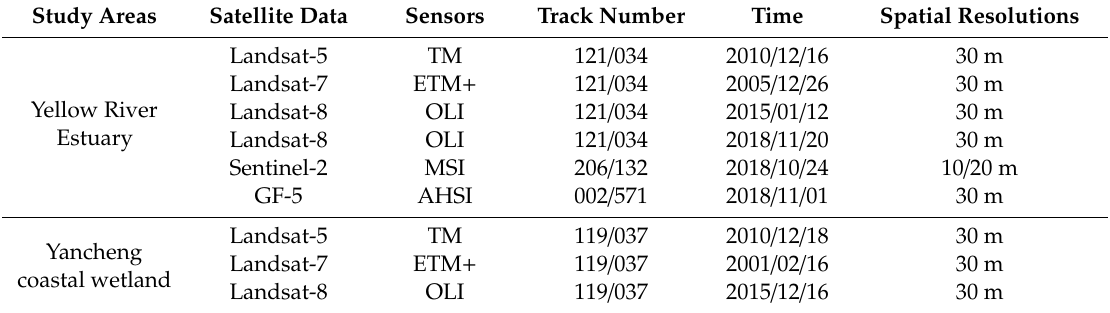
Table 1. List of satellite images used in this